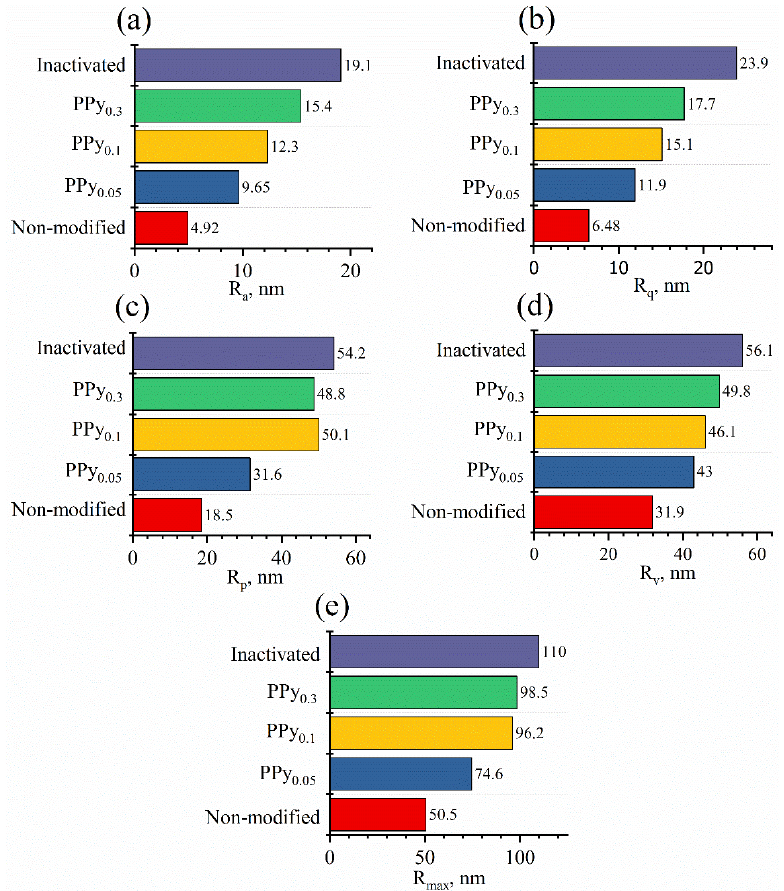
𝑅 (cid:3040)(cid:3028)(cid:3051) .